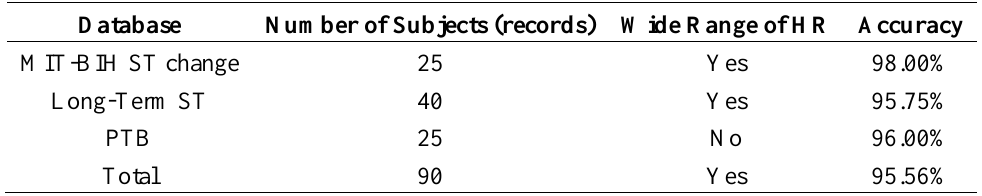
Table 3. Performance using three public ECG